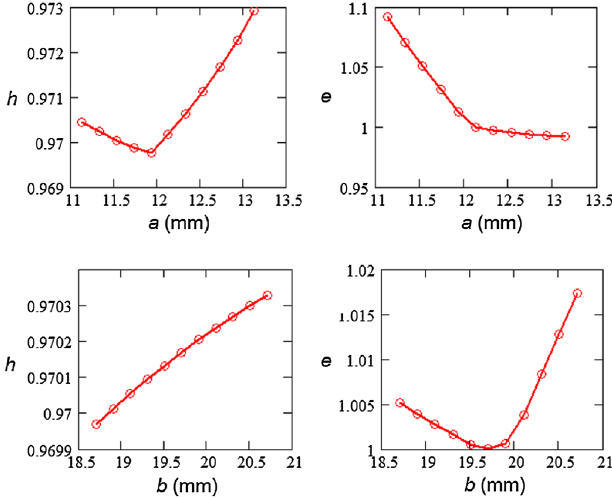
FIG. 7. Dependencies of h and e on a and b near the point of min h